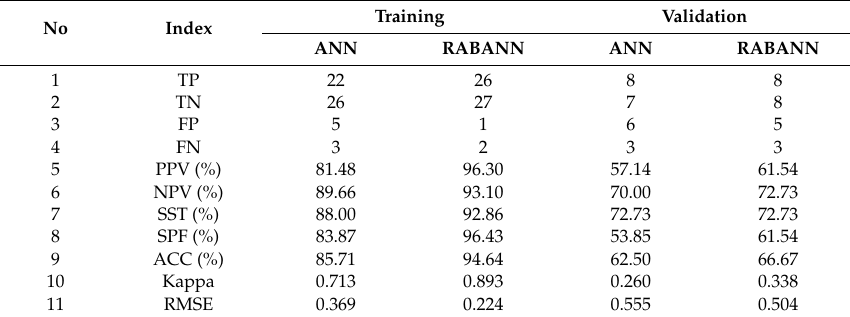
Table 2. Training and validation performances of the models.